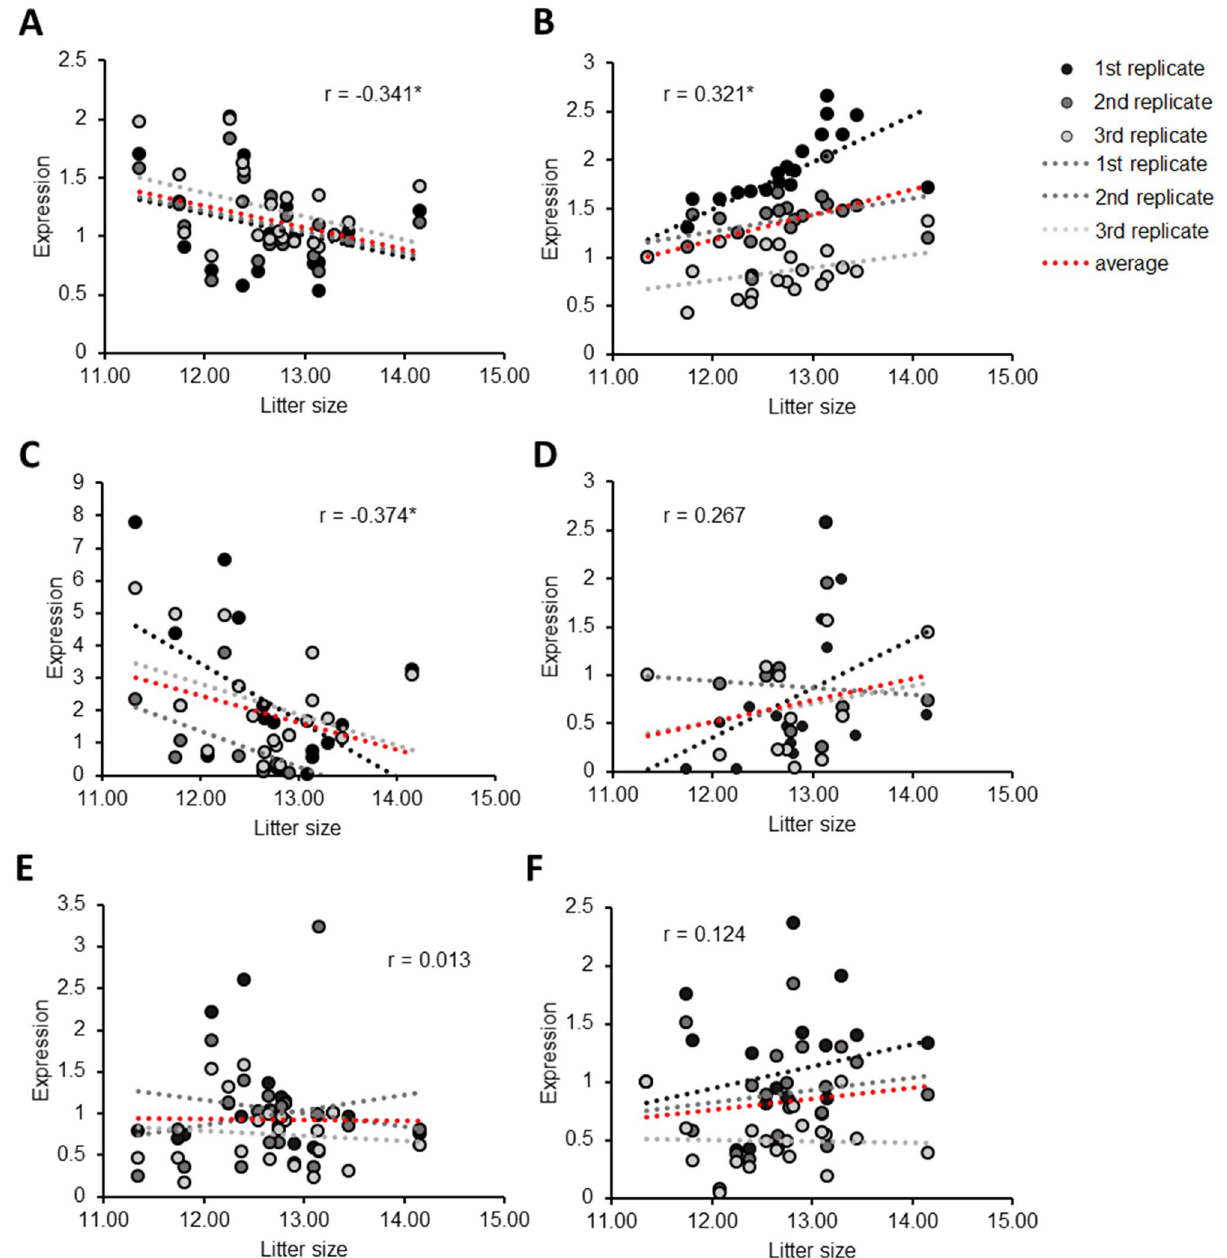
Figure 3. Correlation between EQTN and PRDX4 expression with male fertility. ( A ) linear regression test of EQTN mRNA expression and litter size in isolated RNA without DNase in 20 randomly selected boar spermatozoa. ( B ) Linear regression test of PRDX4 mRNA expression and litter size in isolated RNA without DNase in randomly selected 20 boar spermatozoa. ( C ) Linear regression test of EQTN mRNA expression when gDNA considered with intron primer expression and litter size in isolated RNA without DNase in 20 randomly selected boar spermatozoa. ( D ) Linear regression test of PRDX4 mRNA expression when gDNA was considered with intron primer expression and litter size in isolated RNA without DNase in 20 randomly selected boar spermatozoa. ( E ) Linear regression test of EQTN mRNA expression and litter size in isolated RNA with DNase in 20 randomly selected boar spermatozoa. ( F ) Linear regression test of PRDX4 mRNA expression and litter size in isolated RNA with DNase in 20 randomly selected boar spermatozoa. r, Pearson correlation coefficient; * P < 0.05, calculated using linear regression